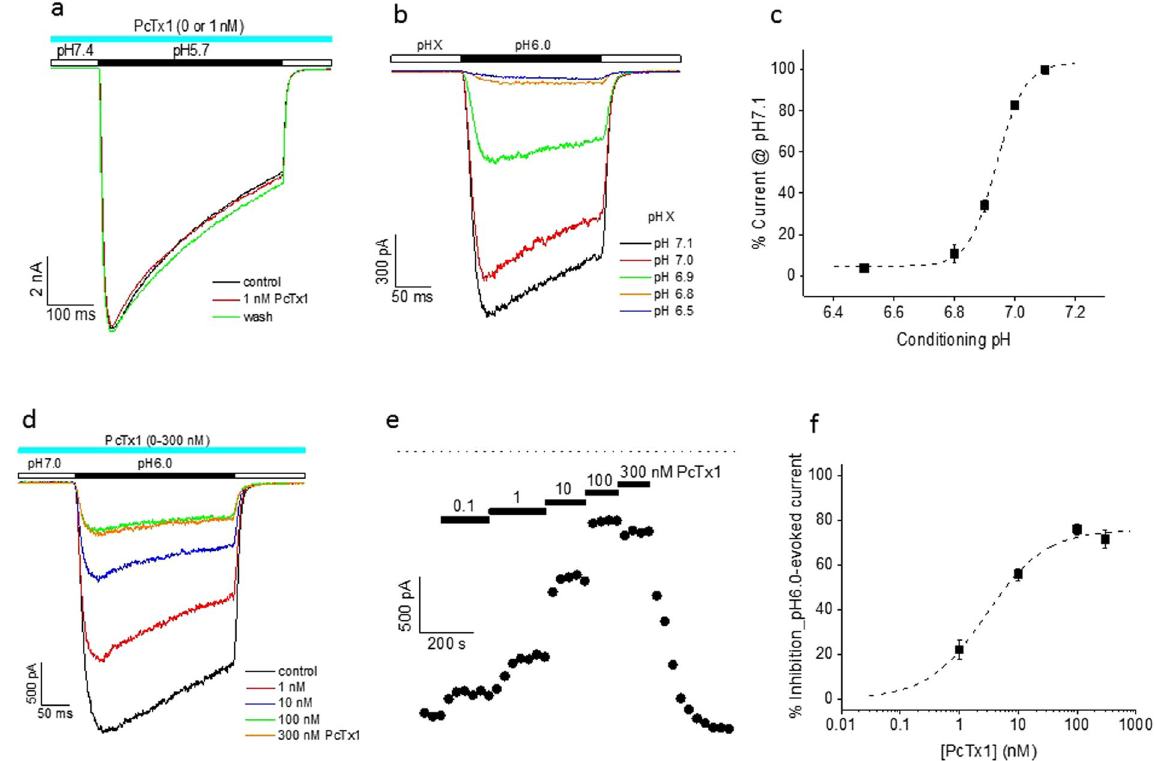
Figure 1. pH dependence of PcTx1 inhibition of ASIC1a/2a stably expressed in CHO cells. ( a ) Current traces from a single cell showing that PcTx1 (1 nM) had no effect on pH5.7-induced currents at the conditioning pH of 7.4. ( b ) Current traces from a single cell showing the dependence of pH6.0-induced current response on the conditioning pH as indicated. ( c ) Average (n = 5) of pH6.0-induced current amplitude (normalized to the value at conditioning pH7.1 for each cell before averaging) as a function of conditioning pH. pH 50 = 6.94 from the best fit (dashed line). The holding potential was − 80 mV. ( d ) Current traces from a single cell showing the inhibition of pH6.0-induced current at various PcTx1 concentrations (1–300 nM). The conditioning pH was 7.0. ( e ) Time course of PcTx1 modulation from a single cell. The dotted line at the top represents the current baseline. ( f ) Average % inhibition (n = 4–6) of pH6.0-induced current as a function of PcTx1 concentration. IC 50 = 2.9 nM and the maximal inhibition was 75.7% from the best fit (dashed